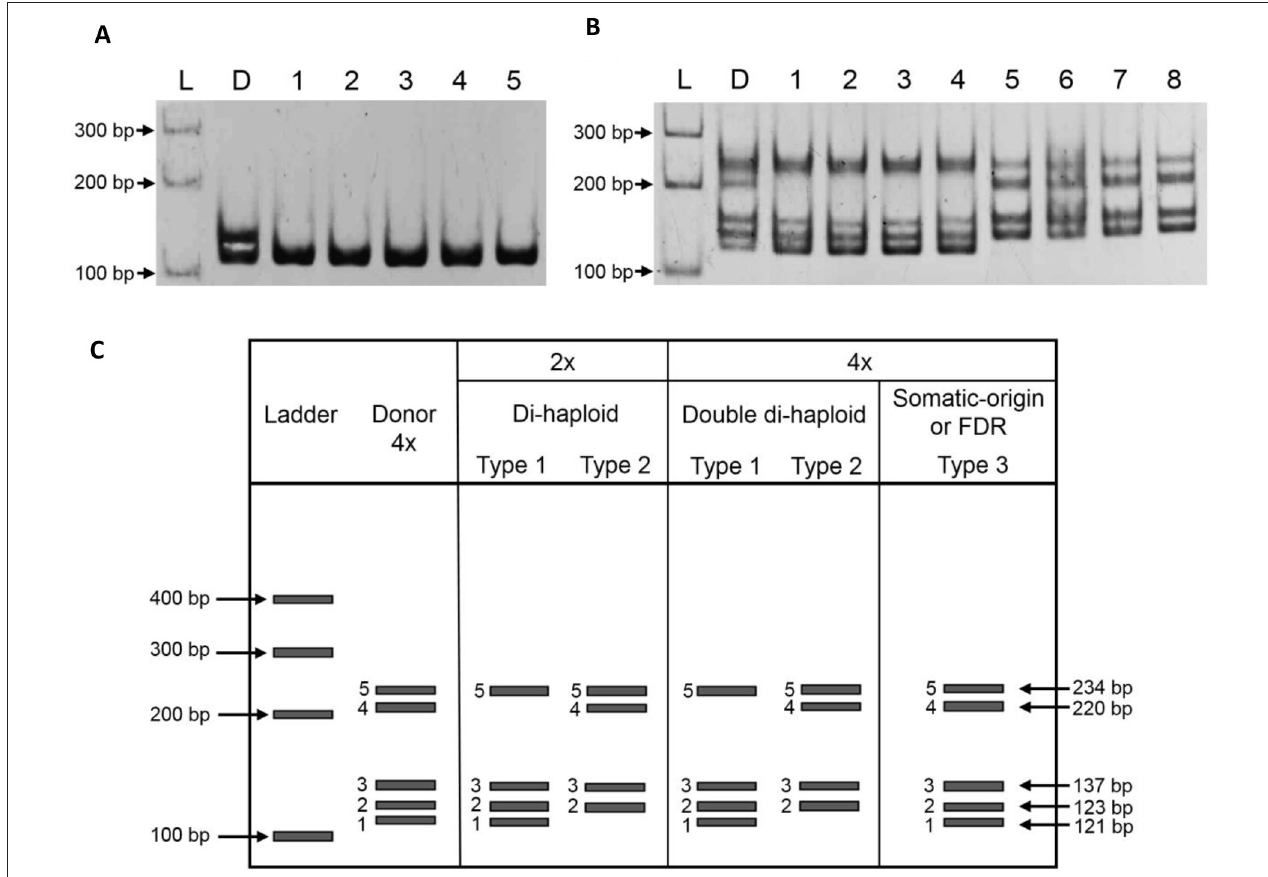
FIGURE 1 | Polyacrylamide gel electrophoresis. (A) H. monacanthus amplified alleles from the microsatellite site Pchi47 . Two alleles were observed in the diploid donor H. monacanthus but only one in the androgenic lines. Lane L: 100-bp DNA ladder; Lane D: donor plant H. monacanthus ; Lanes 1–5: the resulting androgenic lines: 007 (1); 008 (2); 010 (3); 011 (4); and 7057 (5). (B) H. megalanthus amplified alleles from the microsatellite site Pchi44 . Five alleles were observed in the tetraploid donor and somatic or FDR lines and four alleles were observed in the double di-haploid (gamete-derived) lines. Lane L: 100-bp DNA ladder; Lane D: donor plants (accessions 90-002 and 96-663); Lanes 1, 2, 3 and 7, 8: di-haploid gamete-derived lines; Lanes 4–6: double di-haploid (gamete-derived) lines, 432 (4); 1347 (5); 1736 (6). (C) Schematic analysis of band pattern types following amplification with Pchi44 in H. megalanthus . Arrows indicate the positions and nucleotide lengths of the DNA